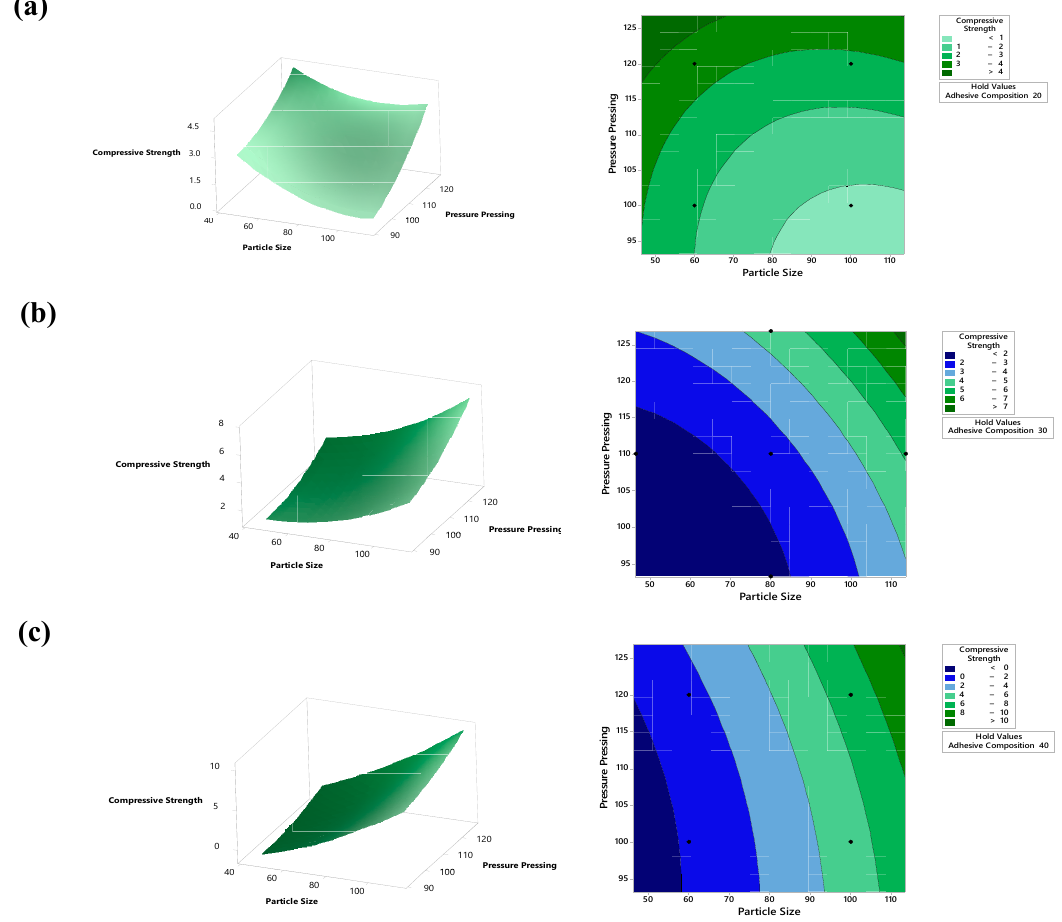
Figure 9. Graph and contour of the surface response of the effect of particle size and pressing pressure on the compressive strength and the adhesive composition ( a ) 80:20 ( b ) 70:30, and ( c ) 60:40. At the 60 mesh particle size, the highest compressive strength of 3.818 kg/cm 2 was obtained under the conditions of the adhesive composition against palm oil charcoal 80:20 and a pressing pressure of 120 kg/cm 2 , while the lowest compressive strength of 0.86 kg/cm 2 was obtained under the condition of the adhesive composition against oil palm charcoal 60:40 and the pressing pressure 100 kg/cm 2 . At 80 mesh particle size, the highest compressive strength of 4871 kg/cm 2 was found in the composition of the adhesive against palm oil charcoal 70:30 and the pressing pressure of 126 kg/cm 2 , and the lowest compressive strength of 1205 kg/cm 2 was found in the composition of the adhesive against palm oil charcoal 70:30 and the pressing pressure of 93 kg/cm 2 . Likewise, with the particle size of 100 mesh, the highest compressive strength of 7526 kg/cm 2 was found in the composition of the adhesive against palm bar charcoal 60:40 and the pressing pressure of 120 kg/cm 2 , while the lowest compressive strength of 1302 kg/cm 2 was found in the composition of the adhesive against charcoal palm stems 80:20 and 100 kg/cm 2 pressing pressure. Figure 10 shows that the change in particle size gave a different heating value under conditions of the same pressing pressure and adhesive composition.